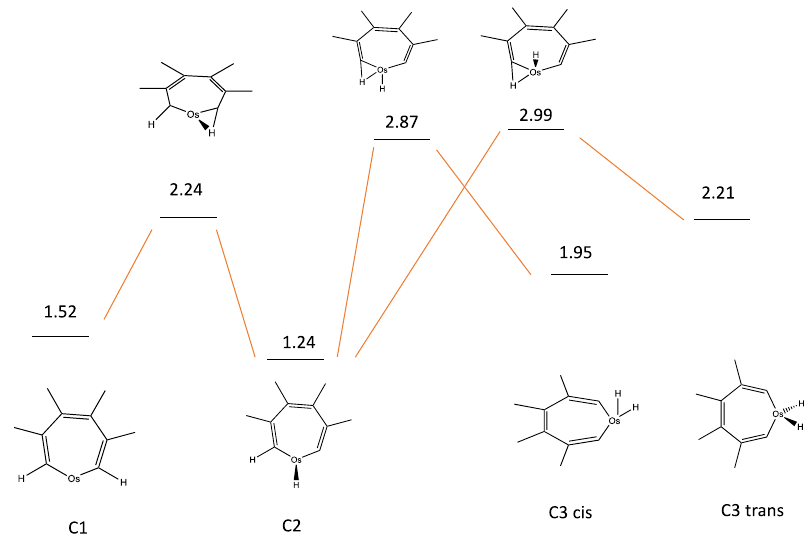
Figure 13. Landmarks in the C path for the production of H 2 .